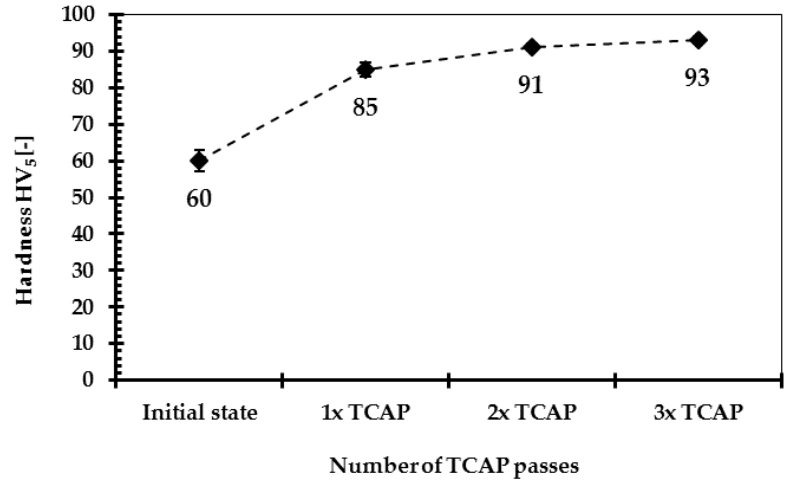
Figure 16. Vickers hardness HV 5 of investigated magnesium alloy AZ61.